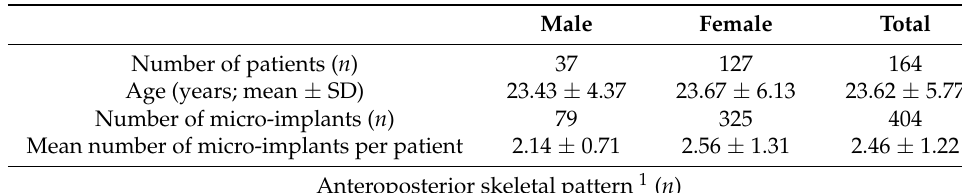
Table 1. Sample characteristics of the study cohort ( n =